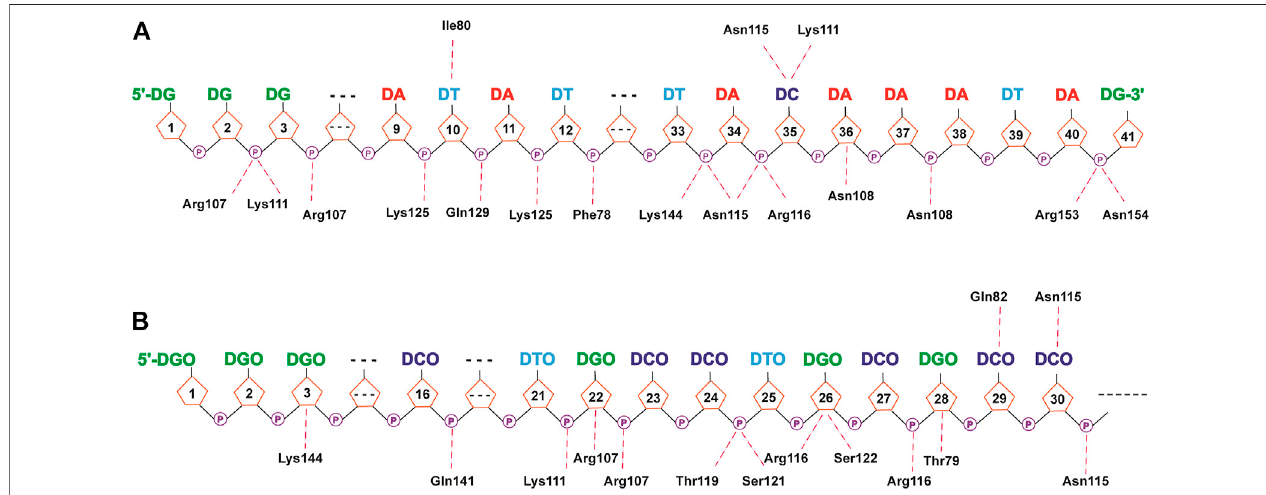
FIGURE 8 | Hydrogen bond networks for protein – DNA complexes. (A) DEK_N/DTA. (B) DEK_N/DTA_OMe. Speci fi c hydrogen bonds are listed above the DNA strand, and non-speci fi c hydrogen bonds are listed below the DNA strand.